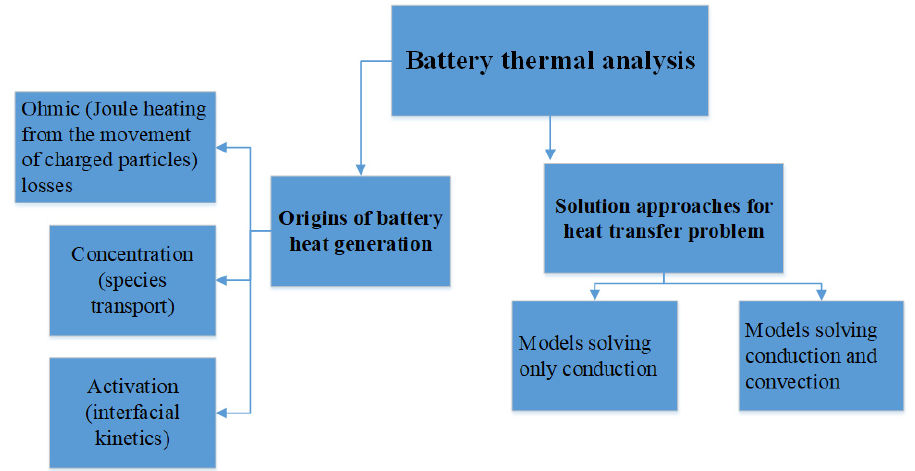
Figure 2. Origin and solution of heat production of lithium-ion batteries [40].